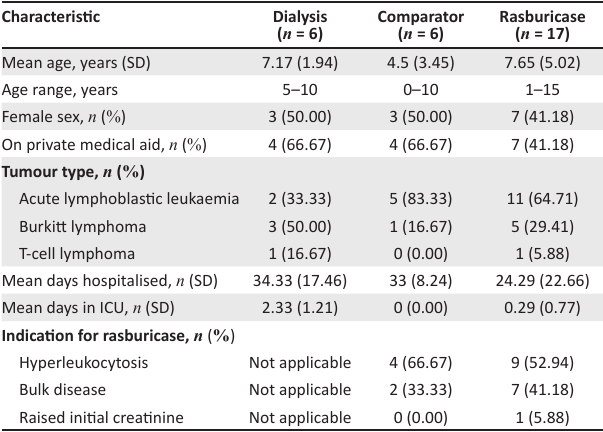
FIGURE 1: Demographic and clinical characteristics. TABLE 2: Demographic characteristics of